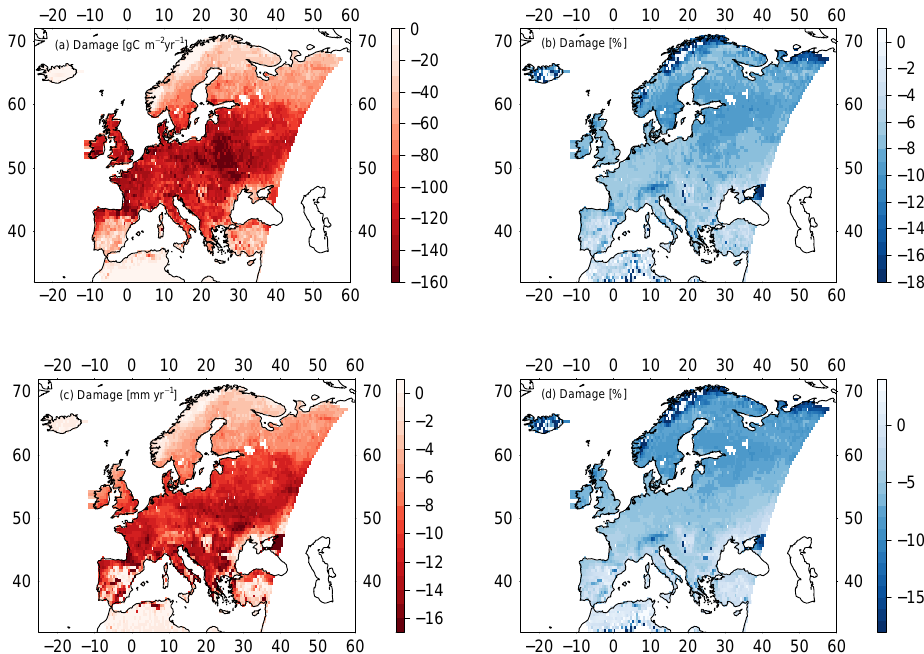
Figure 7. Mean decadal (a) reduction in GPP (gCm − 2 yr − 1 ), (b) percent reduction in GPP, (c) reduction in transpiration (mmyr − 1 ), and (d) percent reduction in transpiration due to ozone damage averaged for the years 2001–2010.